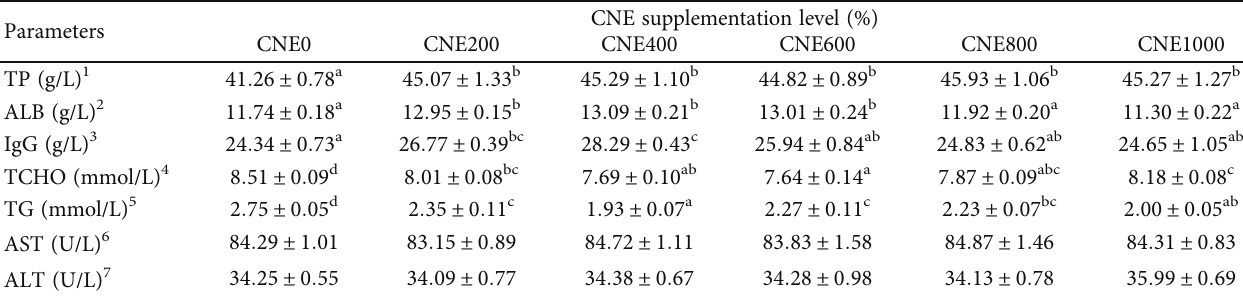
aminotransferase. Values are the mean ± SE of three replicates; means with di ff erent subscripts are signi fi cantly di ff erent ( P < 0 : 05 ).